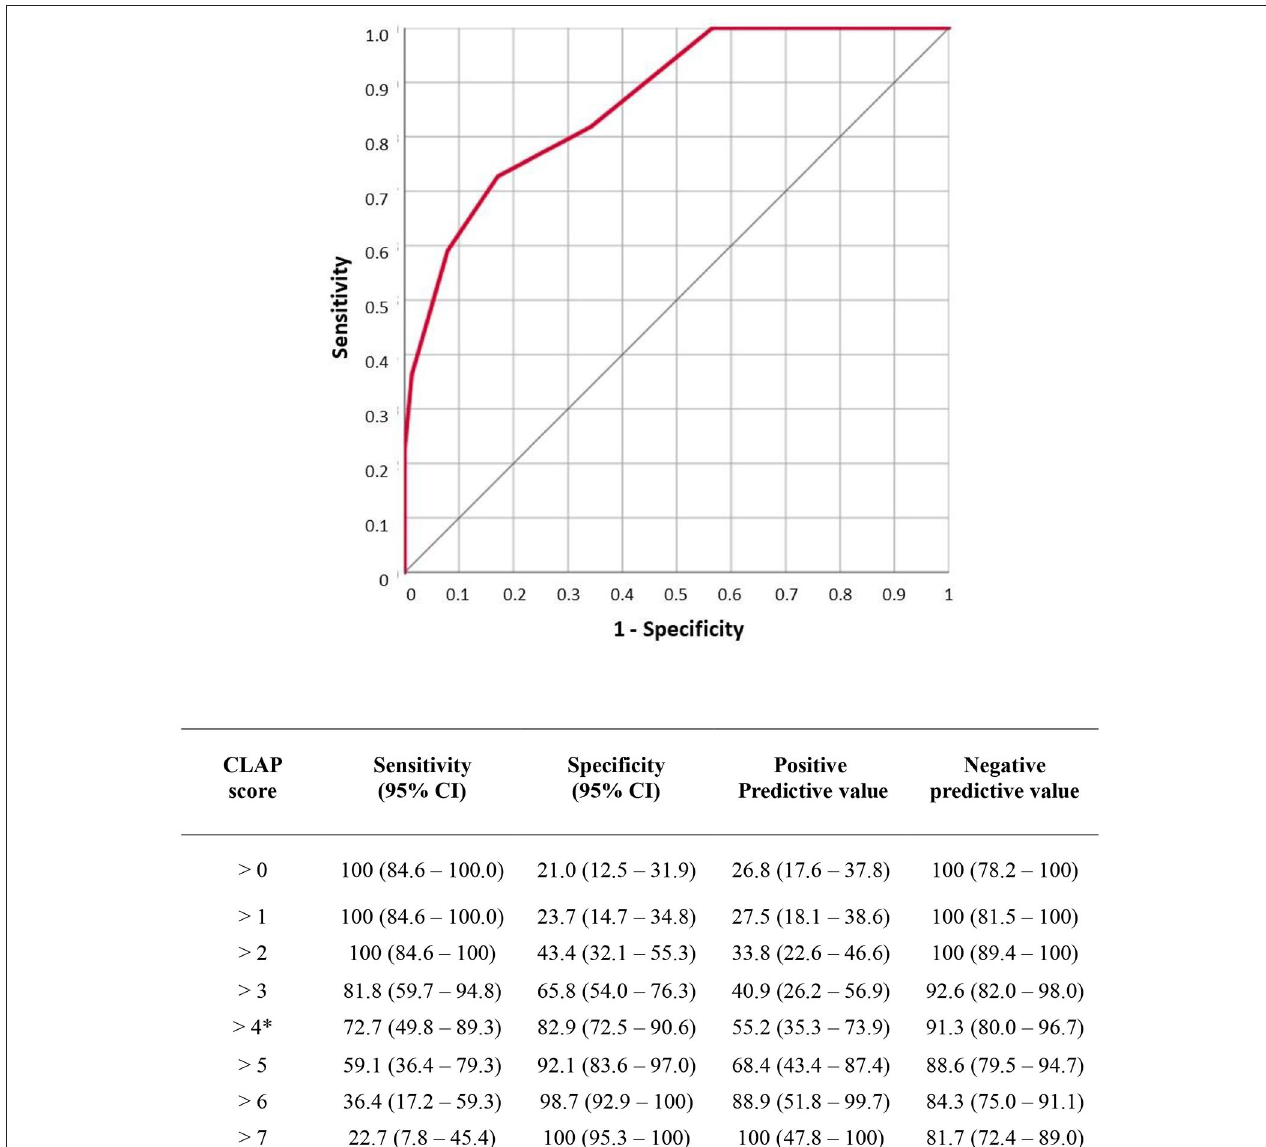
FIGURE 1 | Receiver operating characteristic (ROC) analysis of carcinosis level assessment for peritoneum (CLAP) score. Area under ROC curve is 0.866 (0.782–0.926) p value < 0.001. According to Youden index J the best discriminating value was > 4. Sensitivity, specificity, negative predictive value and positive predictive value for each score level are reported in the